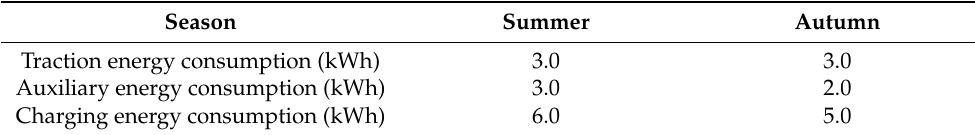
Table 3. The energy consumption demands of station charging in four seasons.